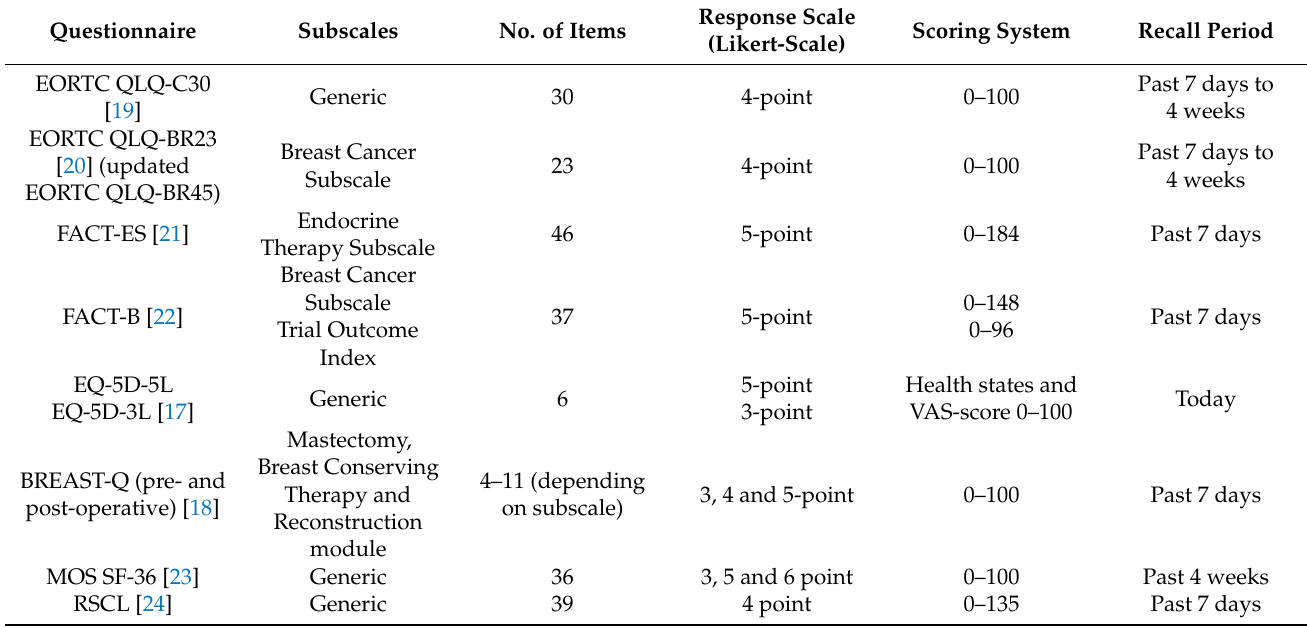
Table 1. Concrete examples of patient-reported outcome measurements (PROMs) used in cancer patients with questionnaire